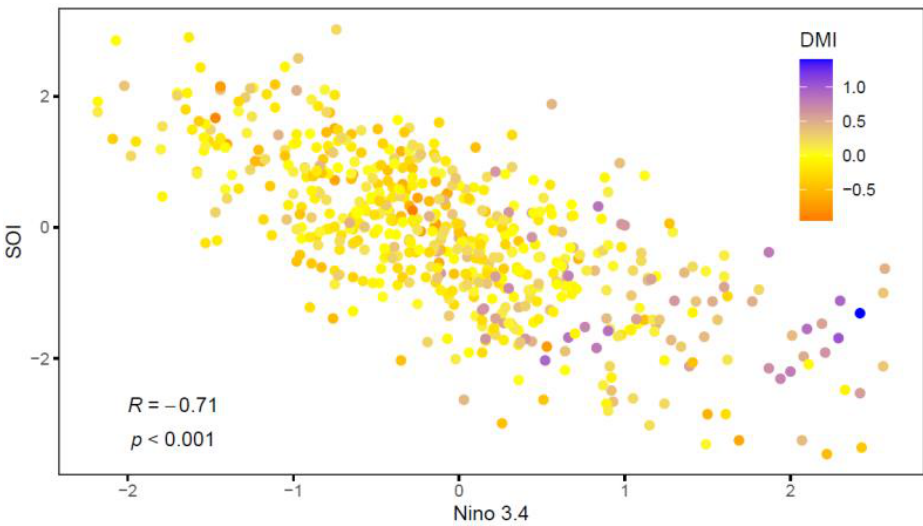
Figure 2. Scatterplot of SOI and Niño 3.4 with DMI levels (1970 – 2018).